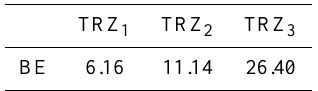
Table 4. BE in terms of Economic Value (millions of Euros) in the TRZ i ( i = 1 , 2 , 3).